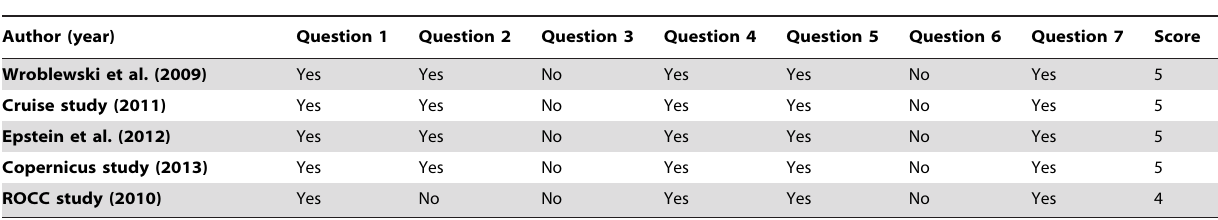
Table 2. Quality assessment of included RCTs in this